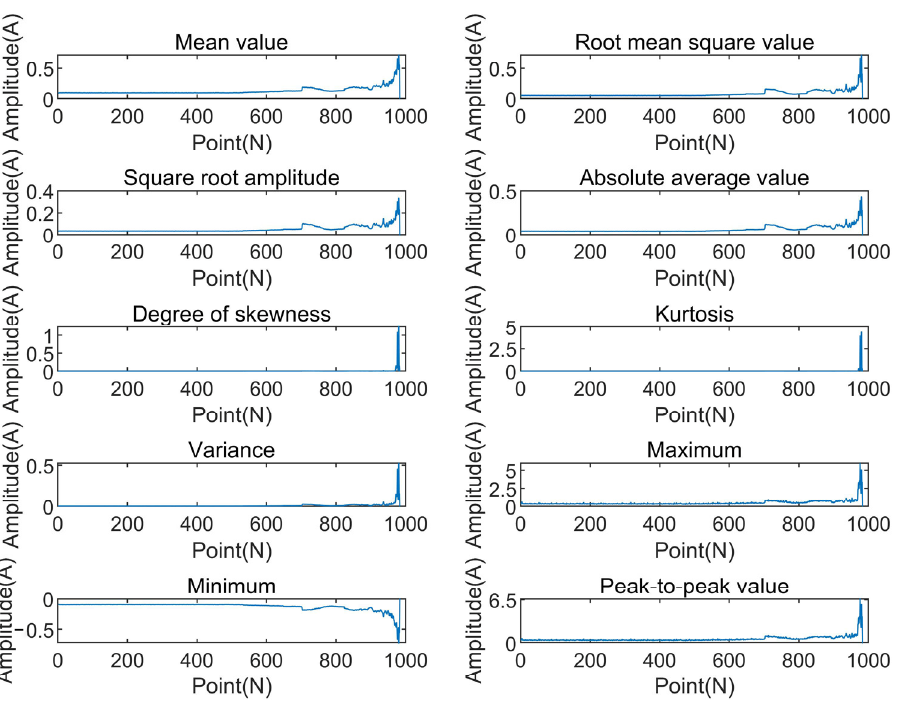
Figure 2. Dimensional indicators of rolling